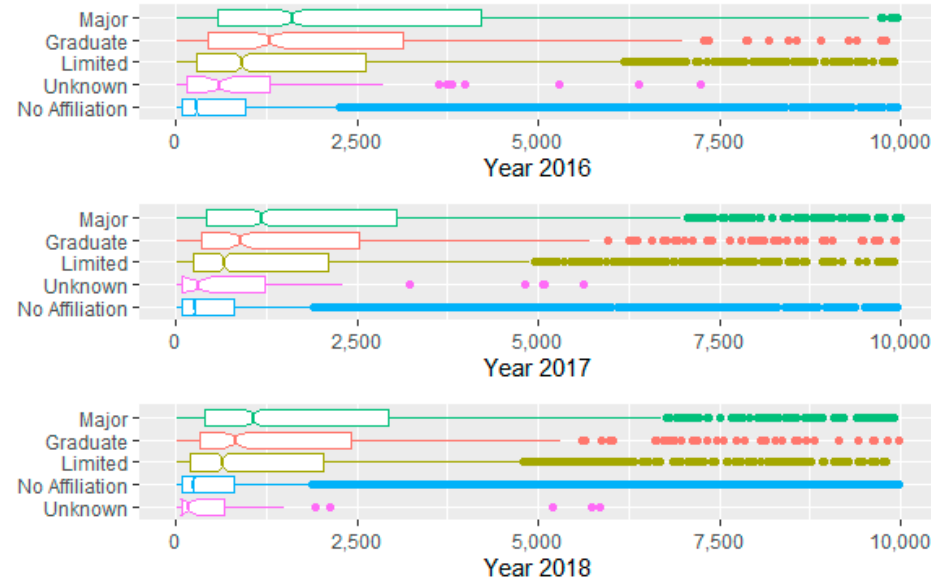
Figure 6. Hierarchical clustered correlation of quantitative variables.